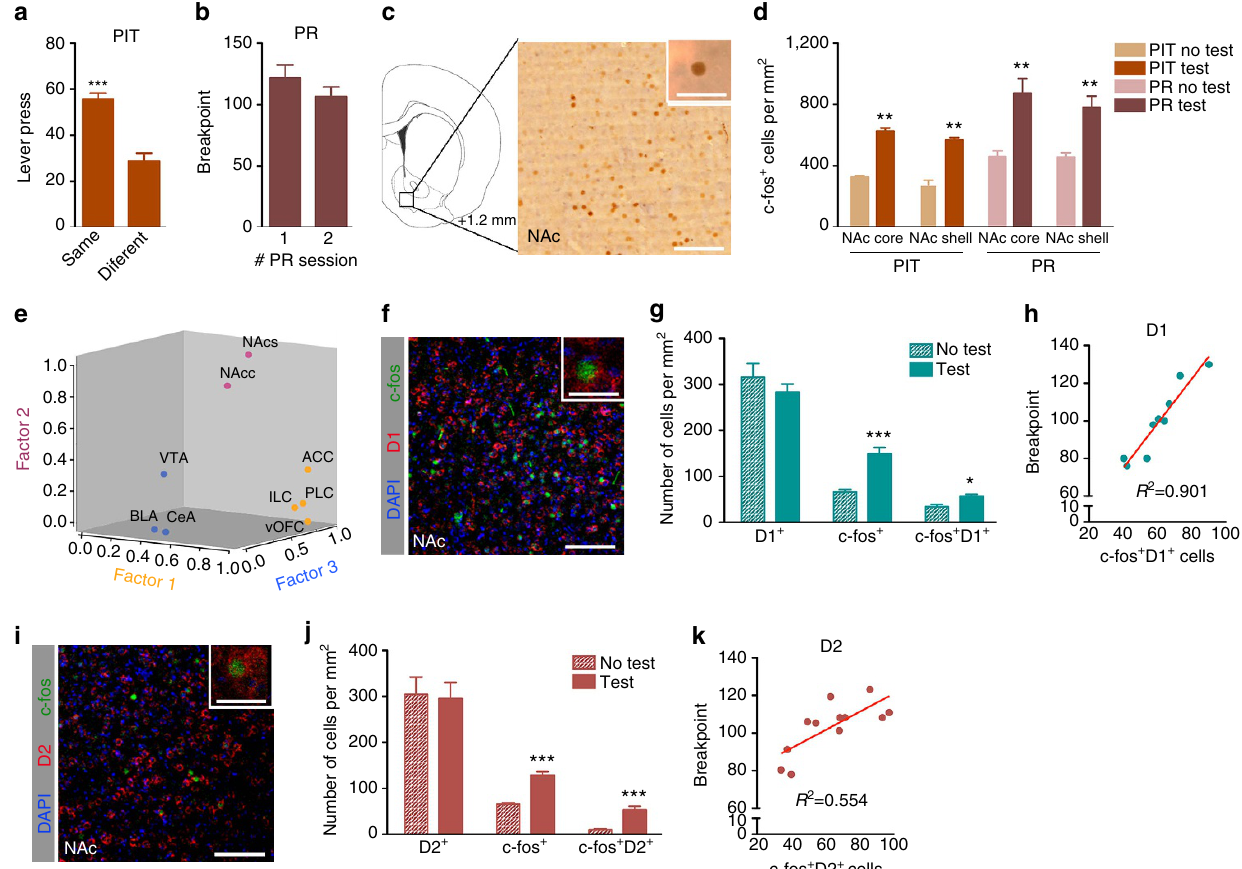
Figure 1 | NAc D1 and D2 neuronal activation predicts performance in motivation-related tasks. ( a ) PIT outcome ( n ¼ 10). ( b ) Breakpoint for two PR sessions ( n ¼ 10). ( c ) Representative immunostaining of c-fos in the NAc; Scale bar: 100 m m; inset: 20 m m. ( d ) Animals performing PIT or PR tests have increased c-fos þ cells in the NAc ( n ¼ 6). ( e ) Principal factor analysis was done to evaluate the contribution of each brain region for the behavioural performance. This analysis shows that the NAc core and shell regions (NAcc and NAcs; factor 2) are grouped distinctively from other limbic regions (BLA, CeA and VTA; factor 3) and from cortical regions that are all grouped together in factor 1 (ACC, PLC, ILC, lOFC and vOFC). Representative images of immunofluorescence for c-fos and dopamine receptor D1 ( f ) or c-fos and dopamine receptor D2 ( i ) in the NAc of animals that performed PR task; Scale bar: 100 m m; inset: 20 m m. Insets represent double positive cells. ( g ) Number of c-fos þ /D1 þ cells and c-fos þ /D2 þ ( j ) cells in the NAc ( n ¼ 6). ( h ) Correlation between individual Breakpoint and number of c-fos þ /D1 þ cells in the NAc ( n ¼ 9). ( k ) Correlation between individual breakpoint and number of c-fos þ /D2 þ cells in the NAc ( n ¼ 12). Error bars denote s.e.m. * P r 0.05, ** P r 0.01, *** P r 0.001. NATURE COMMUNICATIONS|7:11829|DOI: